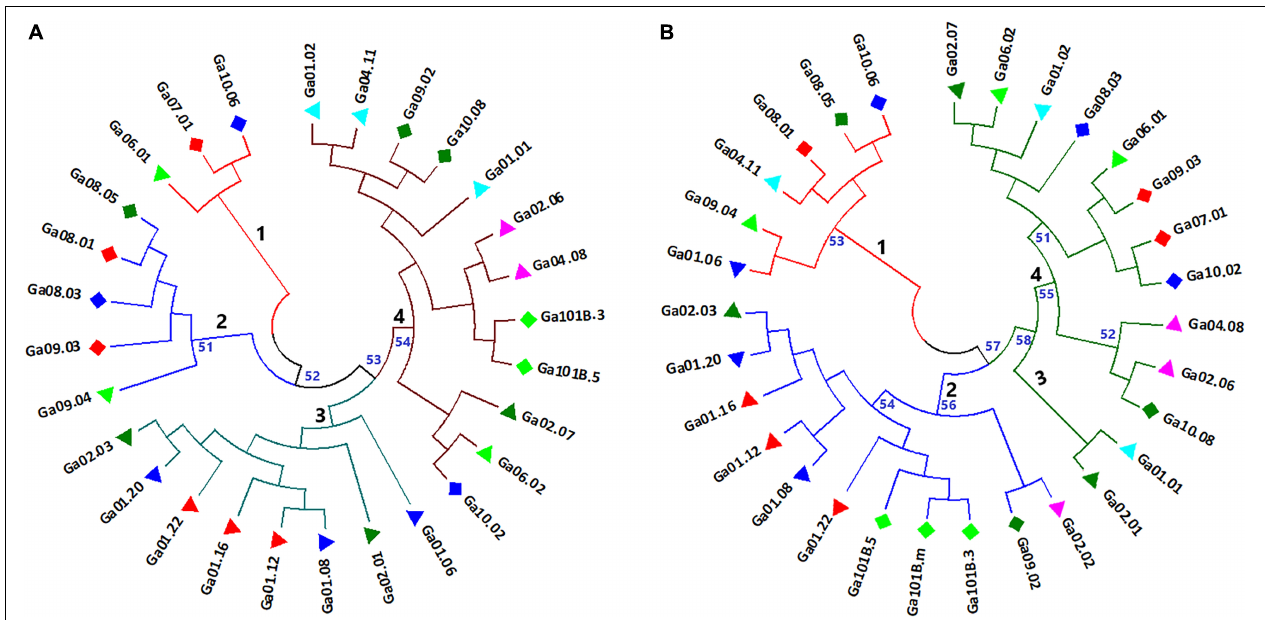
FIGURE 5 | Neighbor-joining trees depicting the clustering pattern of (A) 28 noug genotypes and (B) 30 noug genotypes based on Nei’s standard genetic distances calculated using genotypic data at 5,531 and 1,687 SNP loci, respectively. The numbers in black represent the four clusters of each tree, and the numbers in blue represent the bootstrap support of the corresponding branches (only bootstrap values above 50 are